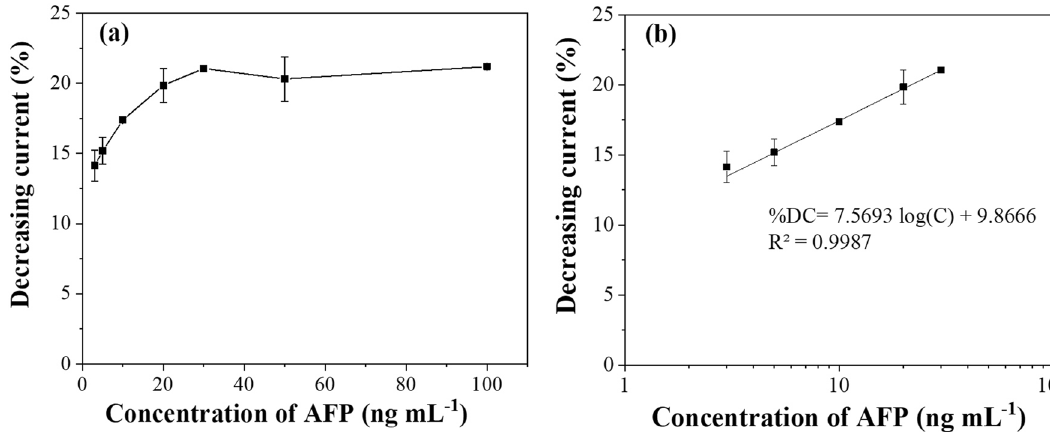
Figure 6. ( a ) A relationship between % decreasing current and different AFP concentrations and ( b ) the calibration graph for AFP detection.